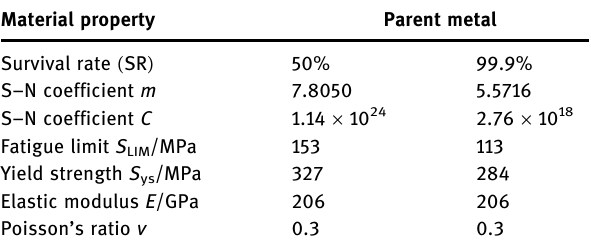
Table 8: Material properties of connection components [ 48 ]